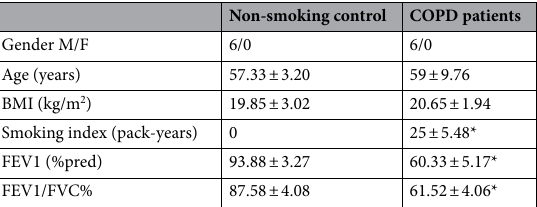
Table 2. The demographic and clinical characteristics of enrolled patients. Data are expressed as median and range. *P < 0.05 versus non-smoking